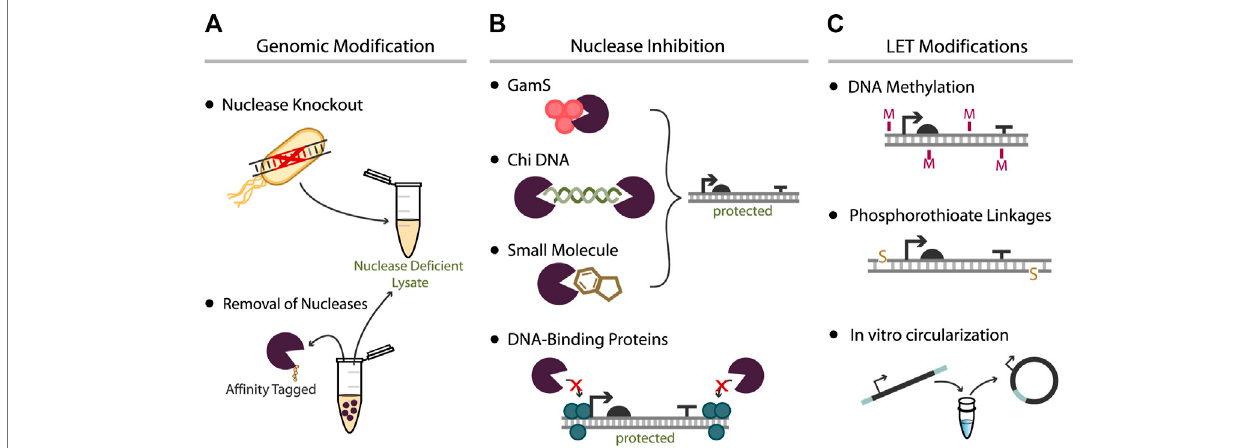
FIGURE 2 | Approaches used to increase expression yield from LETs. (A) Bacteria can be genetically modi fi ed prior to lysate extraction either by deletion of nuclease genes or by the fusion of af fi nity peptides to nuclease genes for later removal during lysate processing. Both methods aim to produce a lysate with negligible